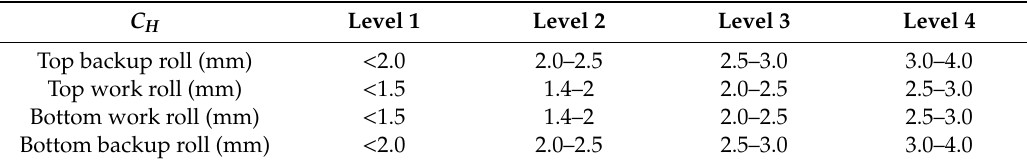
Table 5. The horizontal clearance management levels in the finishing line.